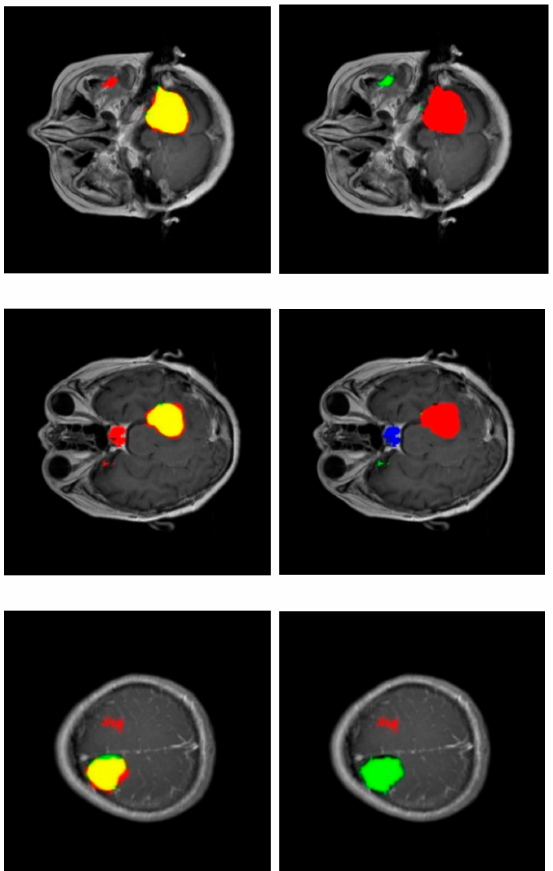
Figure 6. Confusion in segmentation. Color-generated images for proper visualization of regions. Upper row corresponds to a meningioma tumor, middle row to a meningioma tumor, and lower row to a glioma tumor. Right column shows the predicted tumor tags (red: meningioma, green: glioma, blue: pituitary tumor). Left column shows segmentations (red: predicted, green: ground truth and, as a result, the intersection is shown in